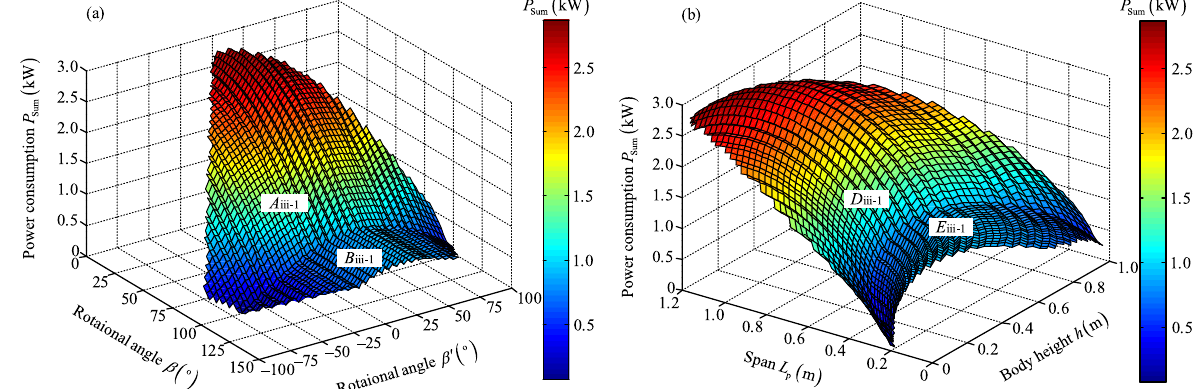
Figure 14 Variable tendency charts of P sum under secondary working conditions iii-1: a With changes in β ′ and β , b with changes in h and L